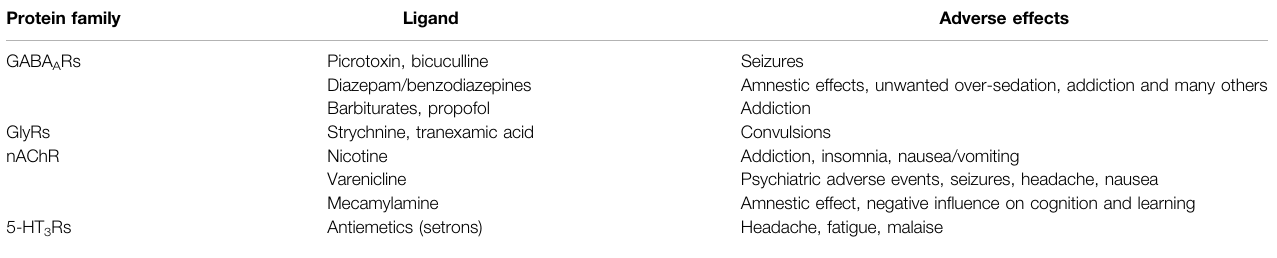
TABLE 1 | Examples of known neuropsychiatric adverse events from the NeuroDeRisk scope elicited by compounds which bind at the different pLGIC family members. Protein